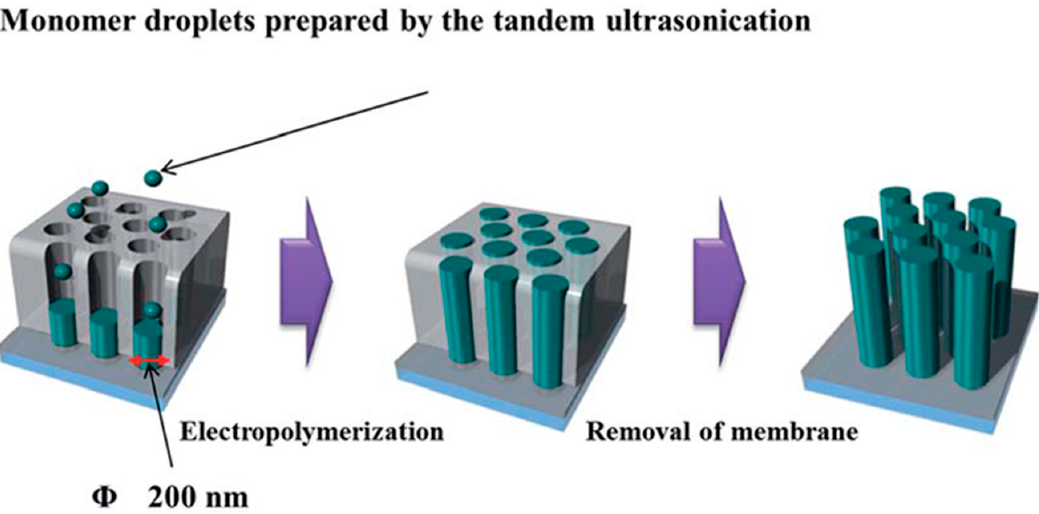
Figure 10. Sketch of preparation of PEDOT nanowires using template electrochemical polymerization. Image reproduced from [96] with permission.